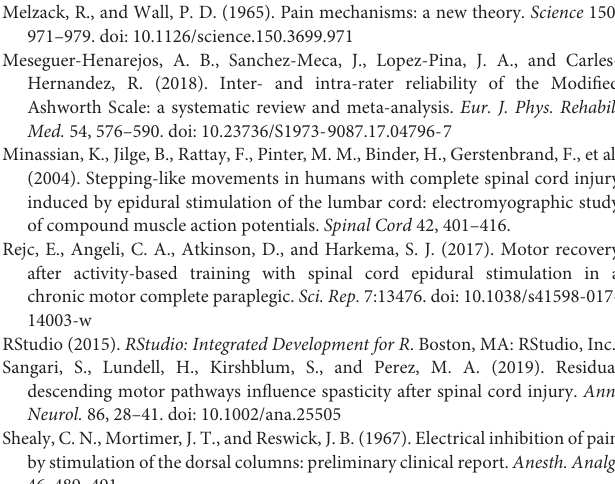
volitional tasks triggered by auditory cues. At follow up 6, the subject achieves bilateral but predominantly left hip internal rotation and flexion as well as left dorsiflexion of the toes. At follow up 9, he again achieves left hip internal rotation and flexion as well as left dorsiflexion of the toes.